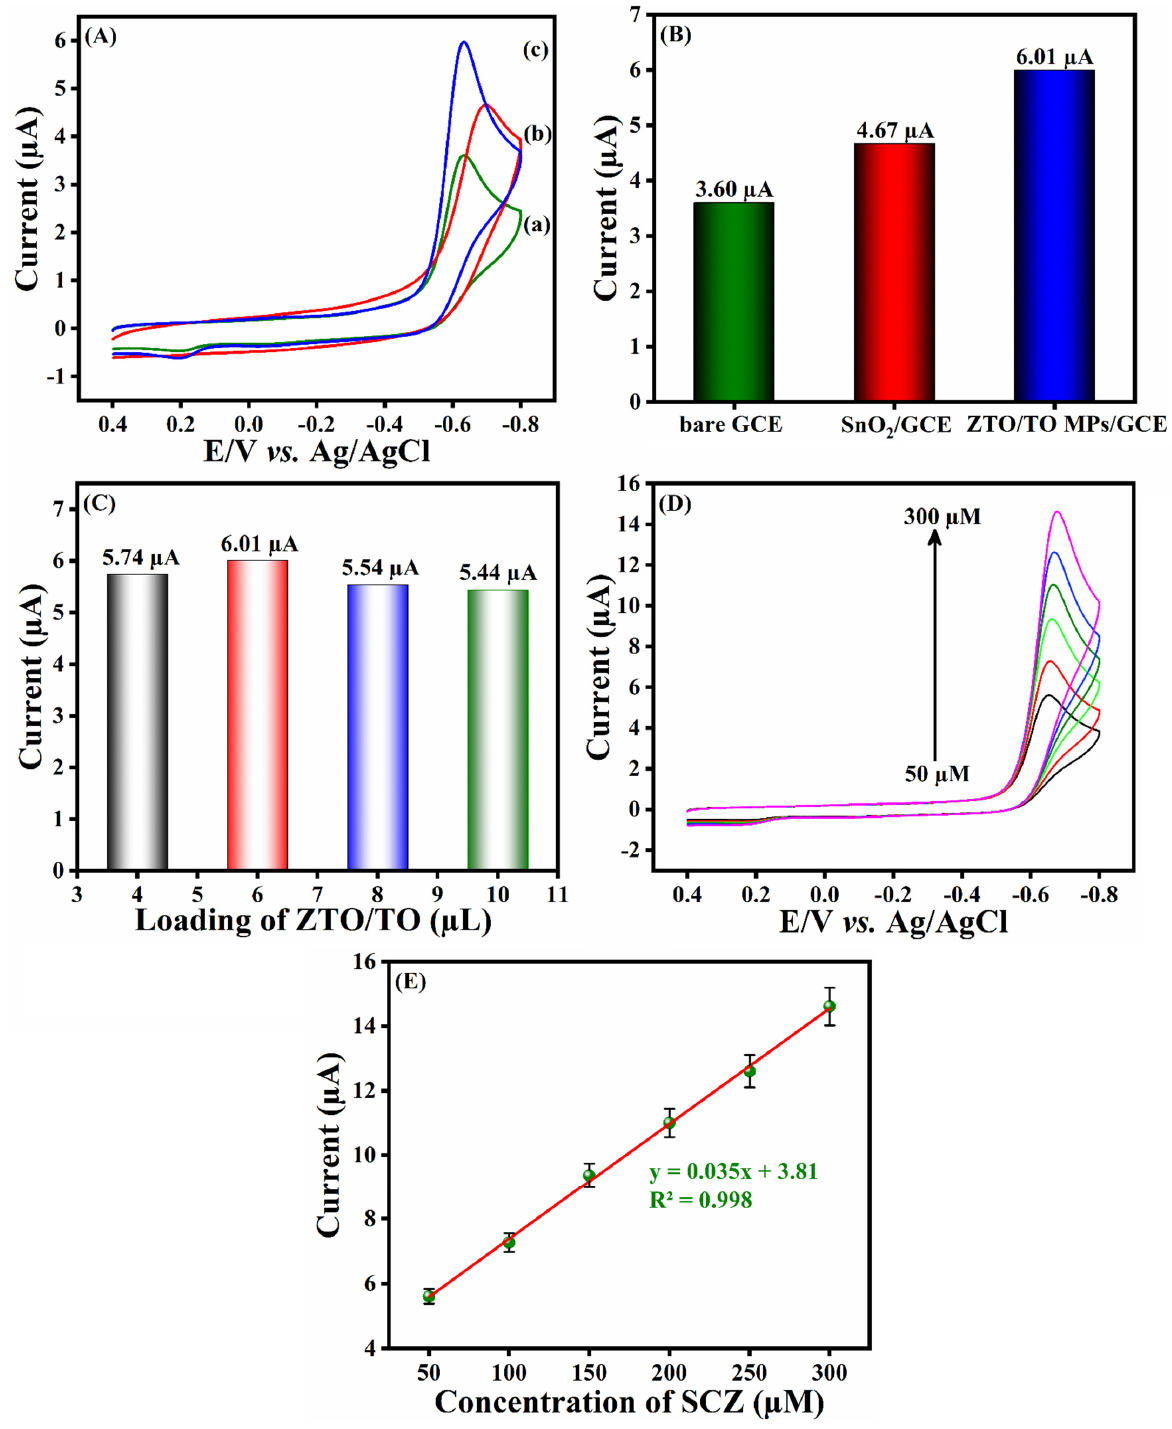
Figure 5. ( A ) CVs at (a) bare GCE, (b) SnO 2 /GCE, and (c) ZTO/TO MPs/GCE for 50 μ M SCZ. ( B ) Comparative bar charts for the cathodic current of SCZ at bare GCE, SnO 2 /GCE, and ZTO/TO MPs/GCE. ( C ) The reduction peak current of 50 μ M SCZ at ZTO/TO MPs with different catalyst loadings. ( D ) CVs of ZTO/TO MPs/GCE with different concentrations of SCZ (50–300 μ M). ( E ) Cathodic current as a function of the SCZ concentration. All of the electrochemical experiments were recorded at 50 mV/s in deoxygenated 0.05 M PBS in the potential region between +0.4 to –0.8 V.